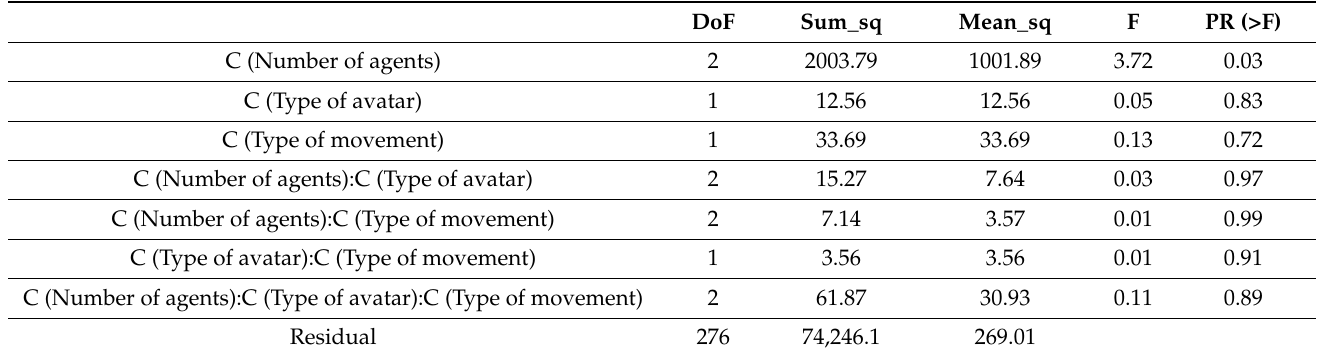
Table 1. Three-way ANOVA for horizontal interference movement.